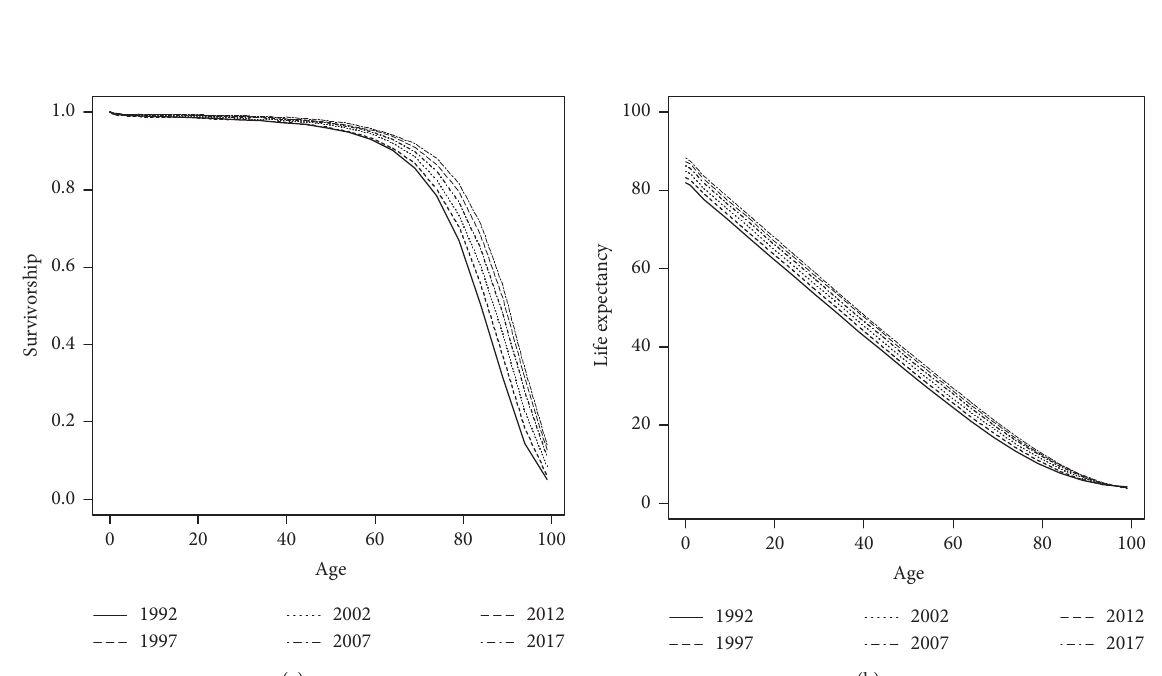
Figure 1: Age-specific mortality and fertility rates for the six populations.